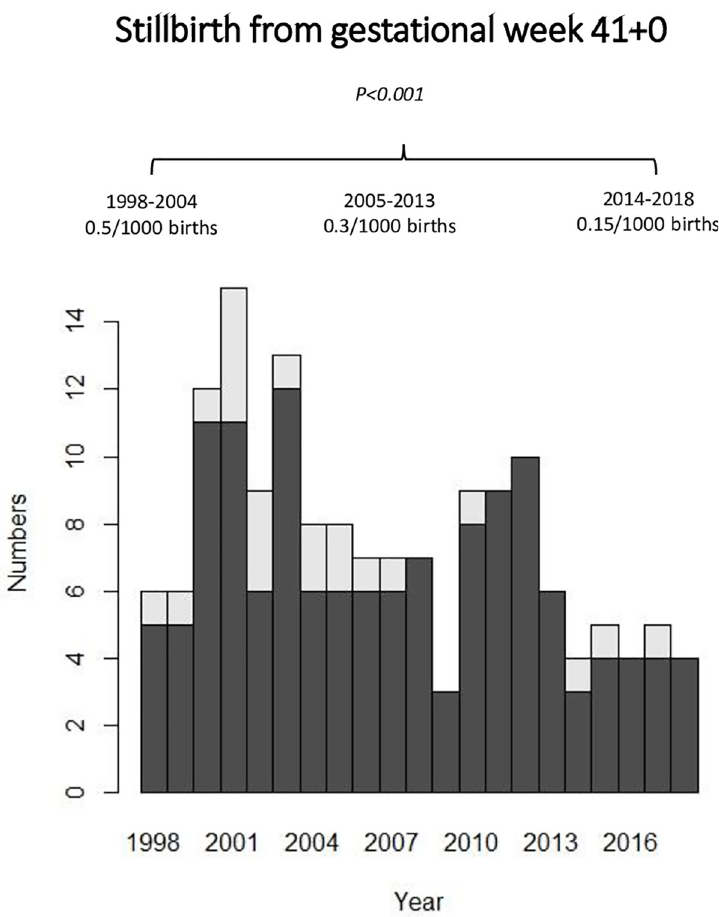
Fig 2. Number of stillbirth cases diagnosed from GW 41+0. Incidences compared between three time periods (1998- 2004, 2005-2013 and 2014-2018). Dark grey indicates cases in GW 41 and light grey indicates cases in GW 42. https://doi.org/10.1371/journal.pone.0251965.g002 PLOS ONE | https://doi.org/10.1371/journal.pone.0251965 May 25,